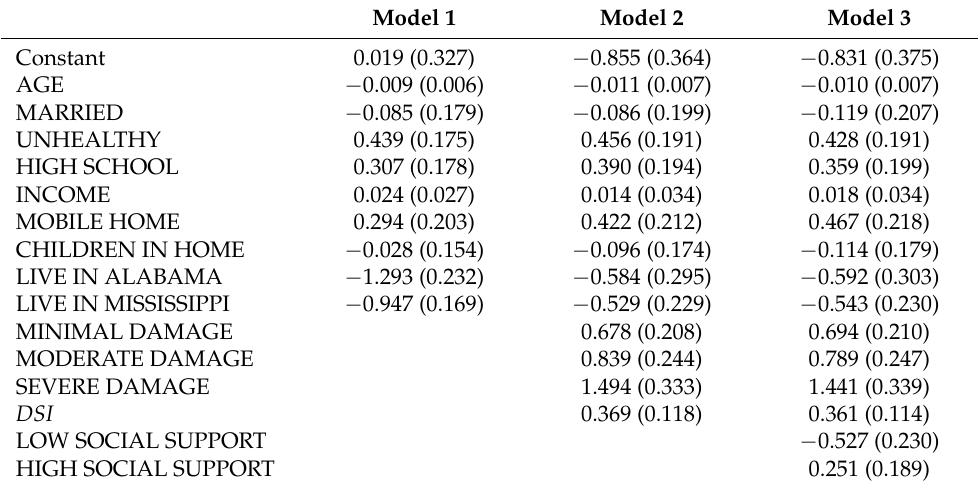
Table 3. The Result from Probit Component of Hurdle Model (Displacement).